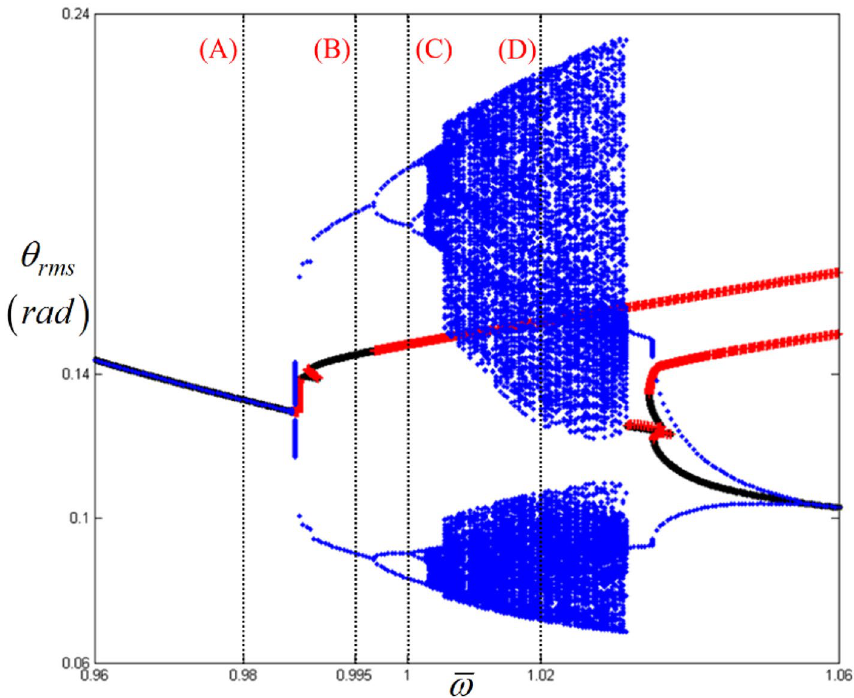
Figure 14. Comparison of HBM and bifurcation diagram with RMS values focused on sub-harmonic response regime. Key: dashed line, HBM result with stable solutions; plus , HBM result with unstable solutions; circle, bifurcation